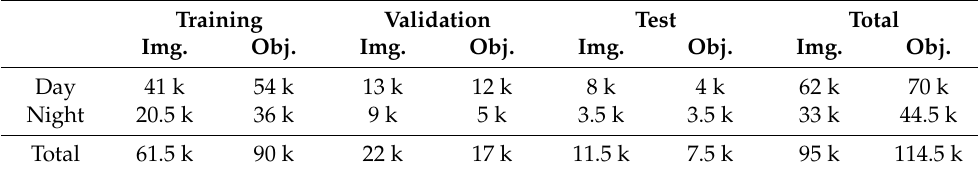
Table 1. Division of the KAIST dataset into the training, validation, and test sets according to the time of day based on the number of images and number of annotated ground truth objects. Training